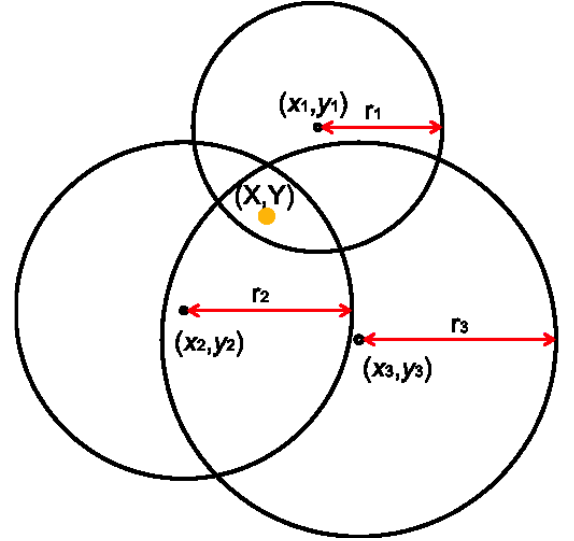
Figure 3. Trilateration